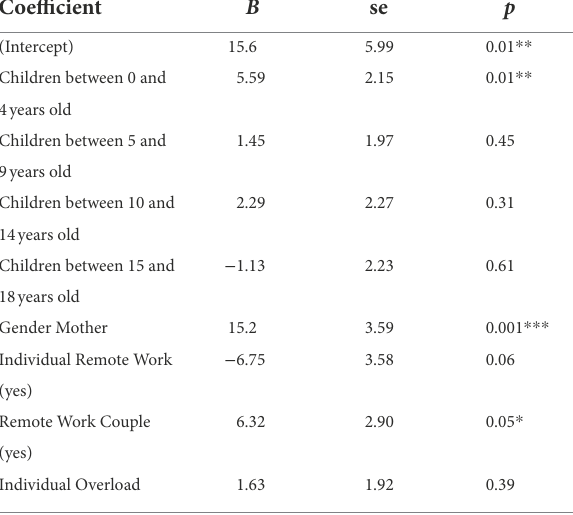
TABLE 3 Objective regression model 1 with multiple imputations.